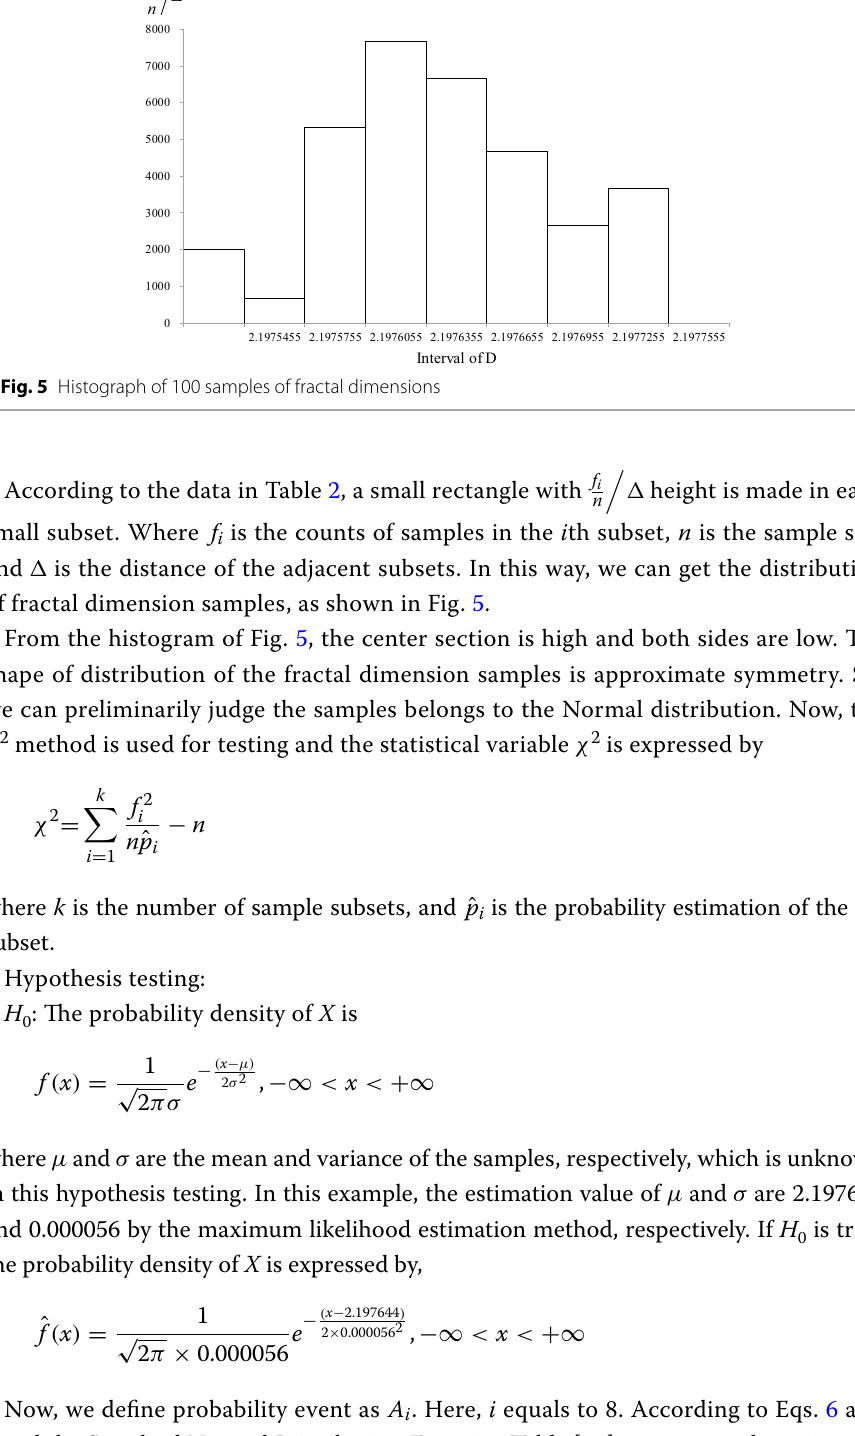
Fig. 5 Histograph of 100 samples of fractal